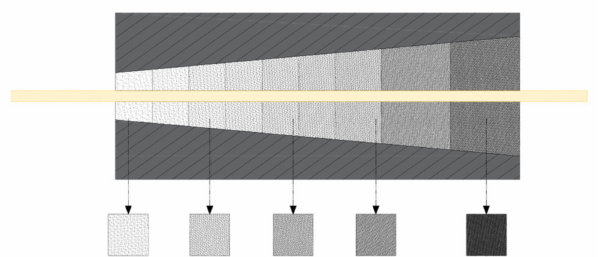
Figure 5. Bonded anchorage filled with Load Transfer Media (LTM). Density of granules gradually decreases from the largest opening to the narrowest end of the socket.